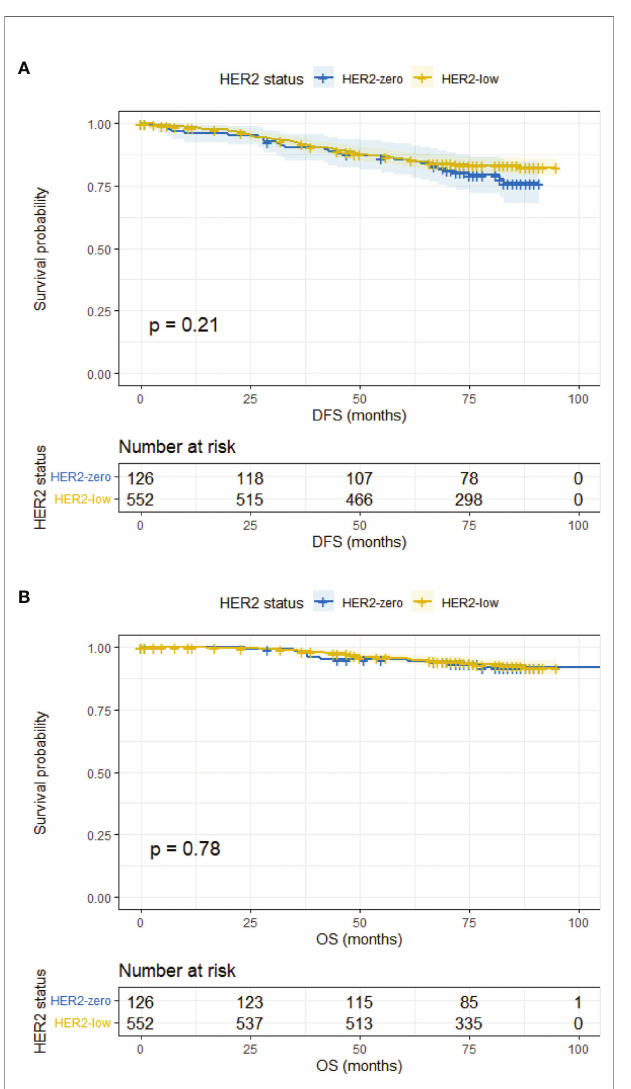
FIGURE 2 | DFS and OS in HR-positive/HER2-zero and HR-positive/HER2- low patients. (A) DFS in HR-positive/HER2-zero and HR-positive/HER2-low patients. (B) OS in HR-positive/HER2-zero and HR-positive/HER2-low patients.